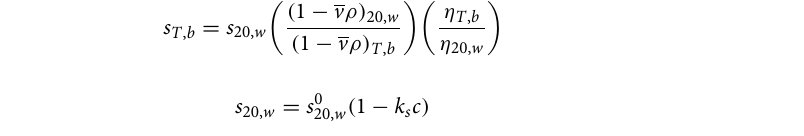
Calculations and figure preparations. The matrices for the superposition of the insulin and IGlu structures were calculated by a least-squares distance minimization algorithm (LSQ, implemented within the program PDBe fold), using the C α-atoms as the guide coordinates. Figures were prepared by the "Chimera" software 23 , COOT 14 for electron density and electrostatic